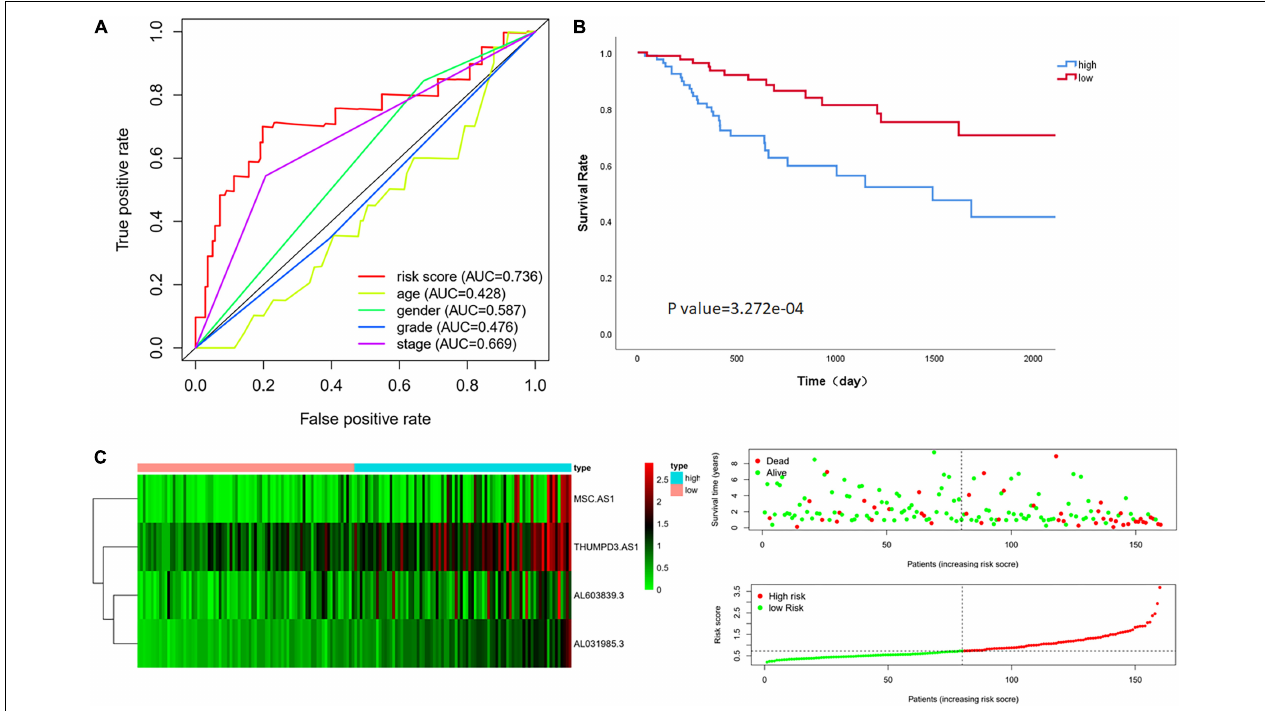
FIGURE 1 | Performance evaluation of the four immune LncRNAs for survival prediction in the training cohort. (A) ROC curve for 5 years of OS. (B) Kaplan–Meier survival curve for high-risk and low-risk groups divided by the median. (C) Heatmaps, distribution of risk scores with survival, and statuses of patients depend on selected immune LncRNA expression.